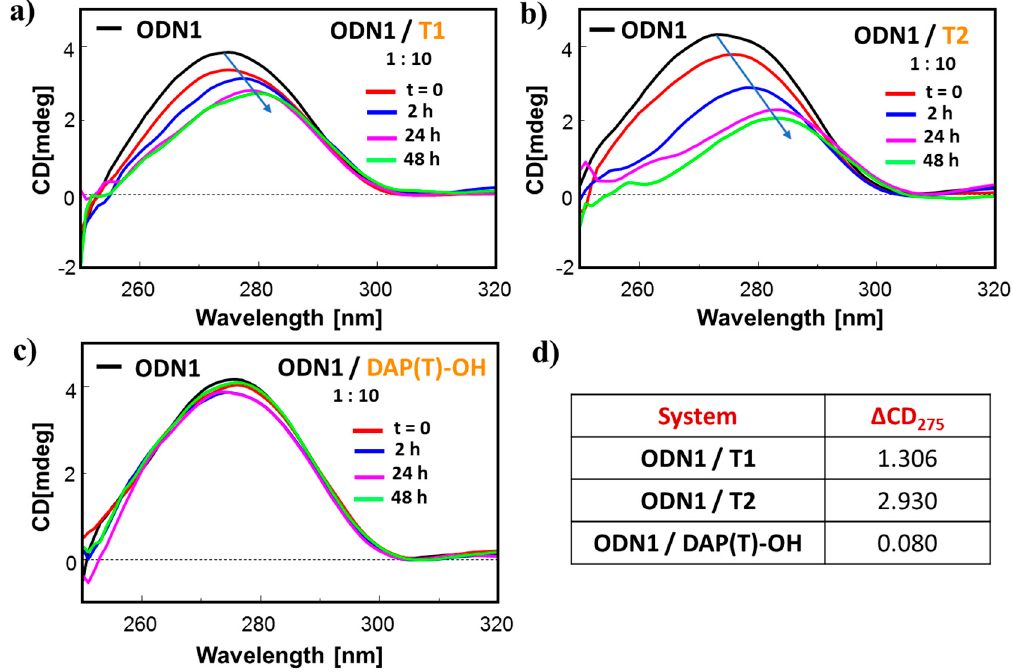
Figure 4. Overlapped circular dichroism (CD) spectra of oligonucleotide 1 (ODN1) (2 µ M concentration), in the absence (black lines) and presence of T1 ( a ), T2 ( b ), and DAP(T)–OH ( c ) (20 µ M each) at di ff erent times (0, 2, 24, 48 h) after the addition of the target molecules. ( d ) Di ff erences in the CD signal at 275 nm between the CD spectra of ODN1 before and after 48 h incubation with each added compound. The experiments were carried out in 100 mM KCl, 7 mM Na 2 HPO 4 / NaH 2 PO 4 , pH = 7.2, at 20 ◦ C (optical path = 1